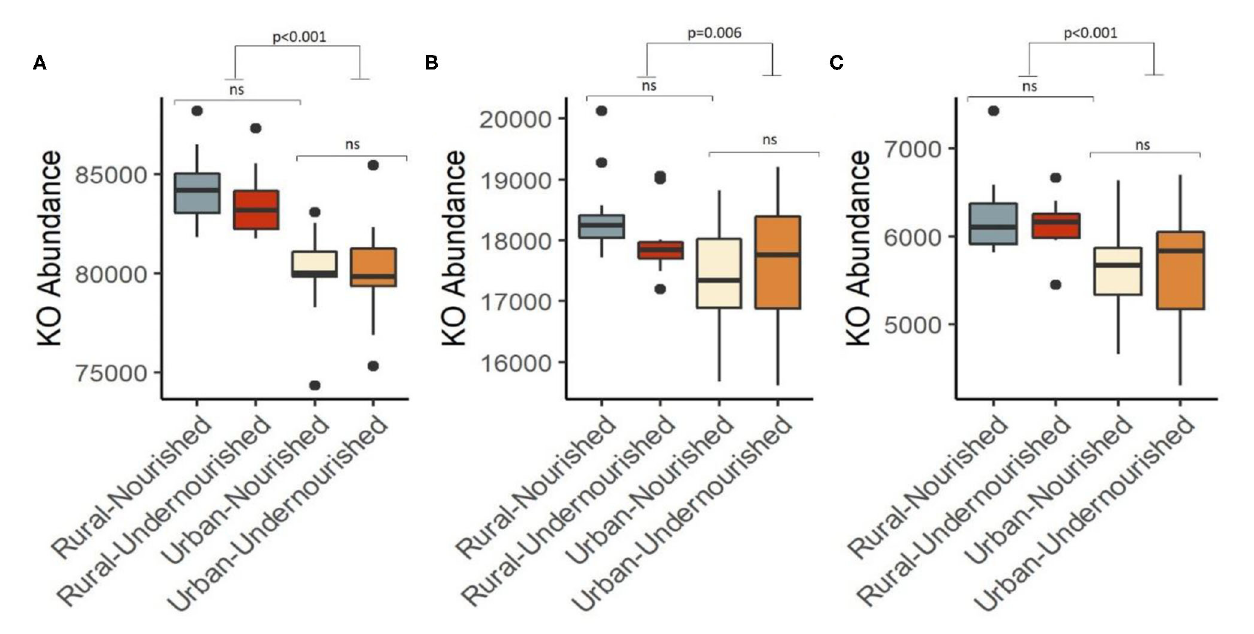
FIGURE 5 | Box and Whisker plot depicting the pathways significantly associated with undernourished and nourished from urban slum and rural settings in (A) Carbohydrate metabolism ( p < 0.001), (B) Lipid metabolism ( p = 0.006), (C) Biosynthesis of secondary metabolites ( p < 0.001). p -values indicate statistical significance from independent t -tests comparing nourished and undernourished study groups in both the locations (i.e., rural normal vs. rural undernourished and urban normal vs. urban-undernourished) and independent t -test based on location (i.e., rural vs. urban-slum). Box-and-whisker plots show high, low, and median values, with lower and upper edges of each box denoting first and third quartiles, respectively. ns indicates non-significant p -values. Black dots represent the